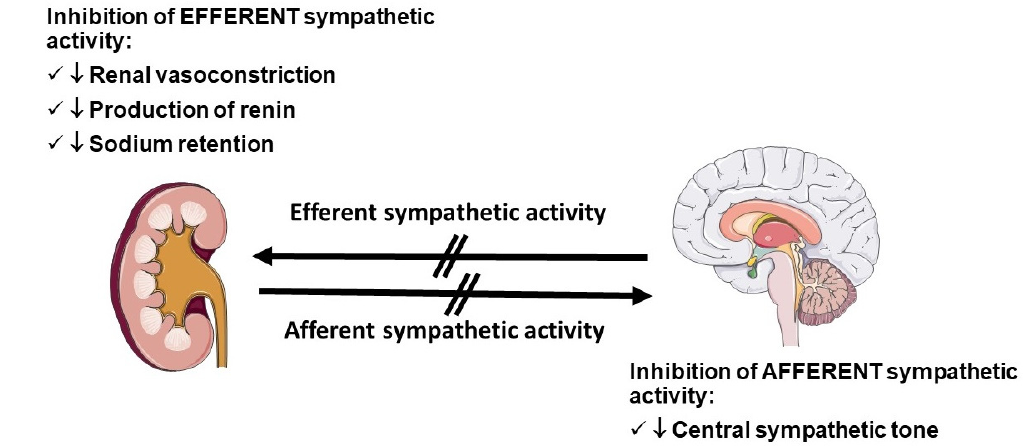
Figure 2. The main effects of inhibition of afferent and efferent sympathetic activity induced by renal denervation.